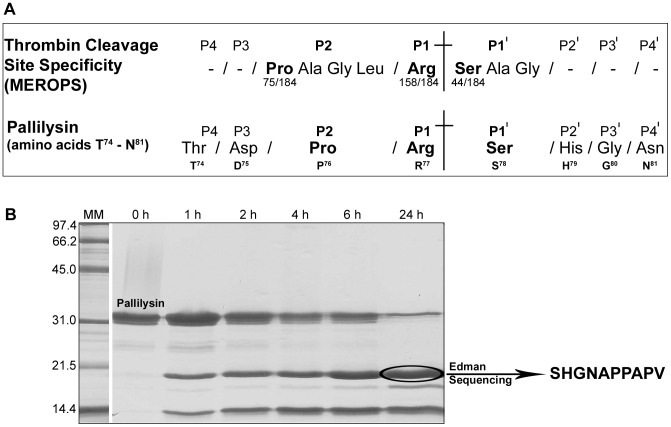
Pallilysin N-terminus is comprised of contiguous thrombin and autocatalytic cleavage sites.(A) The primary structure of pallilysin was manually analyzed for the presence of potential thrombin cleavage sites by comparison to the MEROPS thrombin cleavage site specificity matrix. Shown is a schematic representation of the only potential thrombin cleavage site detected within pallilysin, with substrate subsite residues P4–P4′ (T74–N81) indicated. Highlighted in bold are the most commonly found amino acid residues located at the thrombin substrate subsites P2, P1, and P1′ (based on experimental data from 184 thrombin cleavages [32]) which are compared to potential substrate subsites of pallilysin. (B) Purified recombinant wild-type pallilysin (C24-P237) (100 µg) was incubated with human thrombin (4.5 µg) at 37°C for 24 h. Samples (10 µg) were removed at the indicated intervals and analyzed by SDS-PAGE. The first 10 amino acids of the cleaved pallilysin protein band corresponding to a molecular mass of approximately 18 kDa (circled) were determined by Edman sequencing. The negative control, Tp0453, was not cleaved by thrombin during the same incubation period (data not shown). Numbers to the left of the lanes indicate the size (kDa) of the corresponding molecular mass (MM) markers.